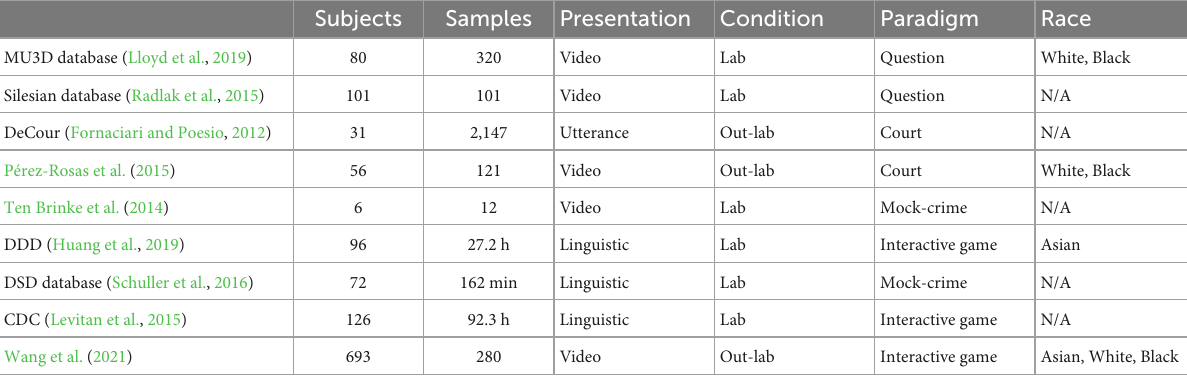
TABLE 1 Summary of publicly available adult deception